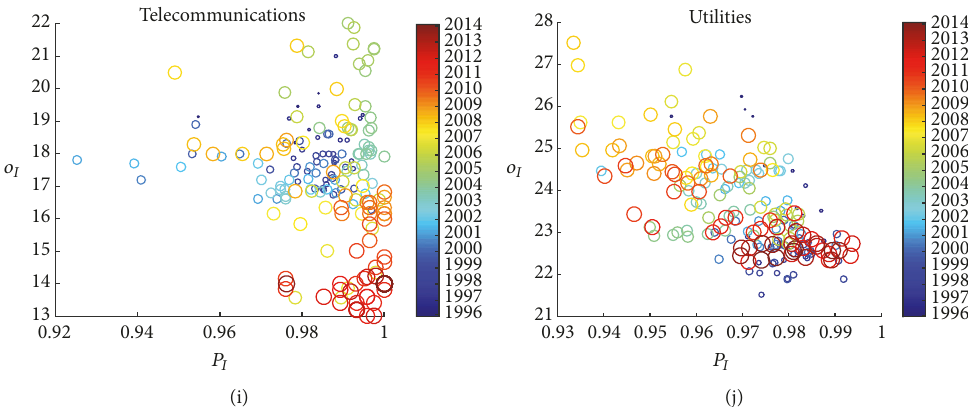
Figure 5: Industries evolution in the overlapping degree/participation coefficient plane. Fixing an industry 𝐼 , we have plotted for each time window a circle whose 𝑦 coordinate is the average overlapping degree 𝑜 𝐼 and whose 𝑥 coordinate is the average participation coefficient 𝑃 𝐼 . Points at different times are characterised by different sizes (small to large) and colours (legend on the right). In (a)–(j) we show the results, respectively, for Basic Materials, Consumer Goods, Consumer Services, Financials, Health Care, Industrials, Oil & Gas, Technology, Telecommunications, and